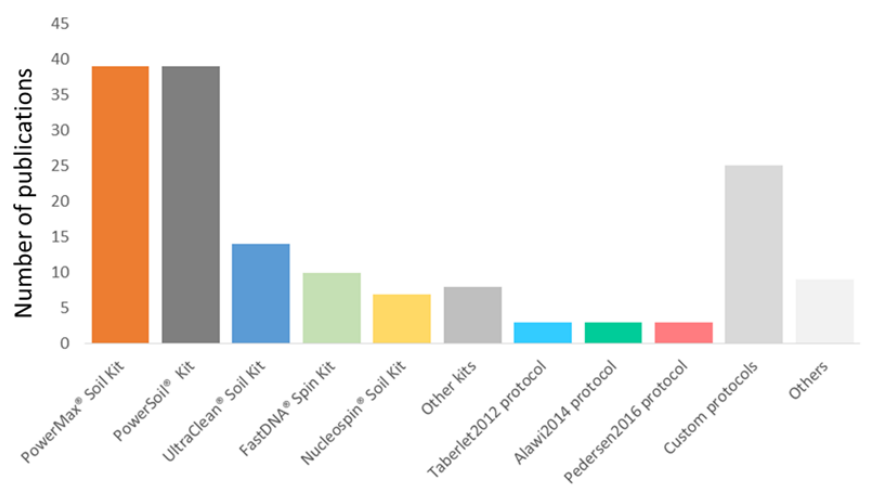
Figure 4. DNA extraction protocols used in the 160 publications compiled in Table S1.